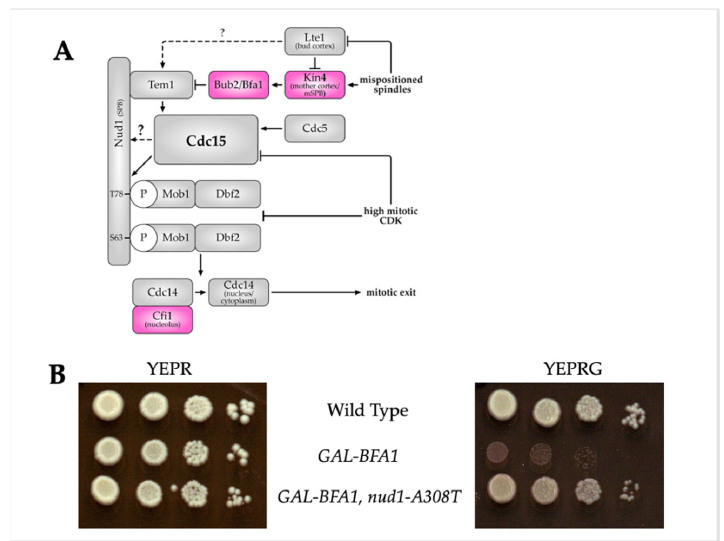
Figure 1. The nud1-A308T allele suppresses the growth defect of GAL-BFA1 cells. ( A ) The mitotic exit network components and regulators are shown. Proteins that inhibit mitotic exit are depicted in red boxes, while activators are colored as grey boxes. The majority of the components assemble on the SPBs. The cellular locations of components that are not on this structure are indicated in parentheses underneath the protein names. See text for details. ( B ) Wild-type (AS3), GAL-BFA1 (AS5), and GAL-BFA1 nud1-A308T (AS53) strains were grown in YEP + Raffinose (YEPR) overnight and 10-fold serial dilutions were spotted on YEPR (left) or YEPR + Galactose (YEPRG; right). The plates were incubated at 25 ◦ C for 3